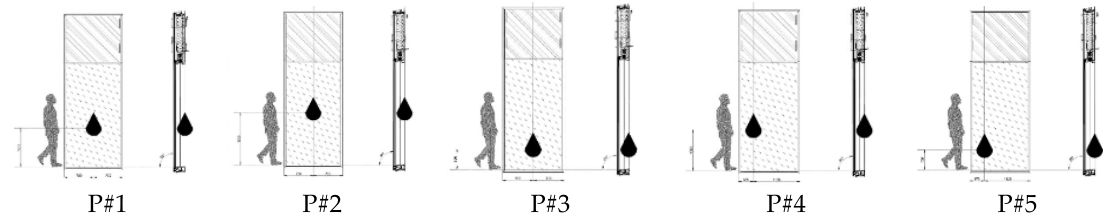
Figure 9. Schematic representation of P# n impact points.